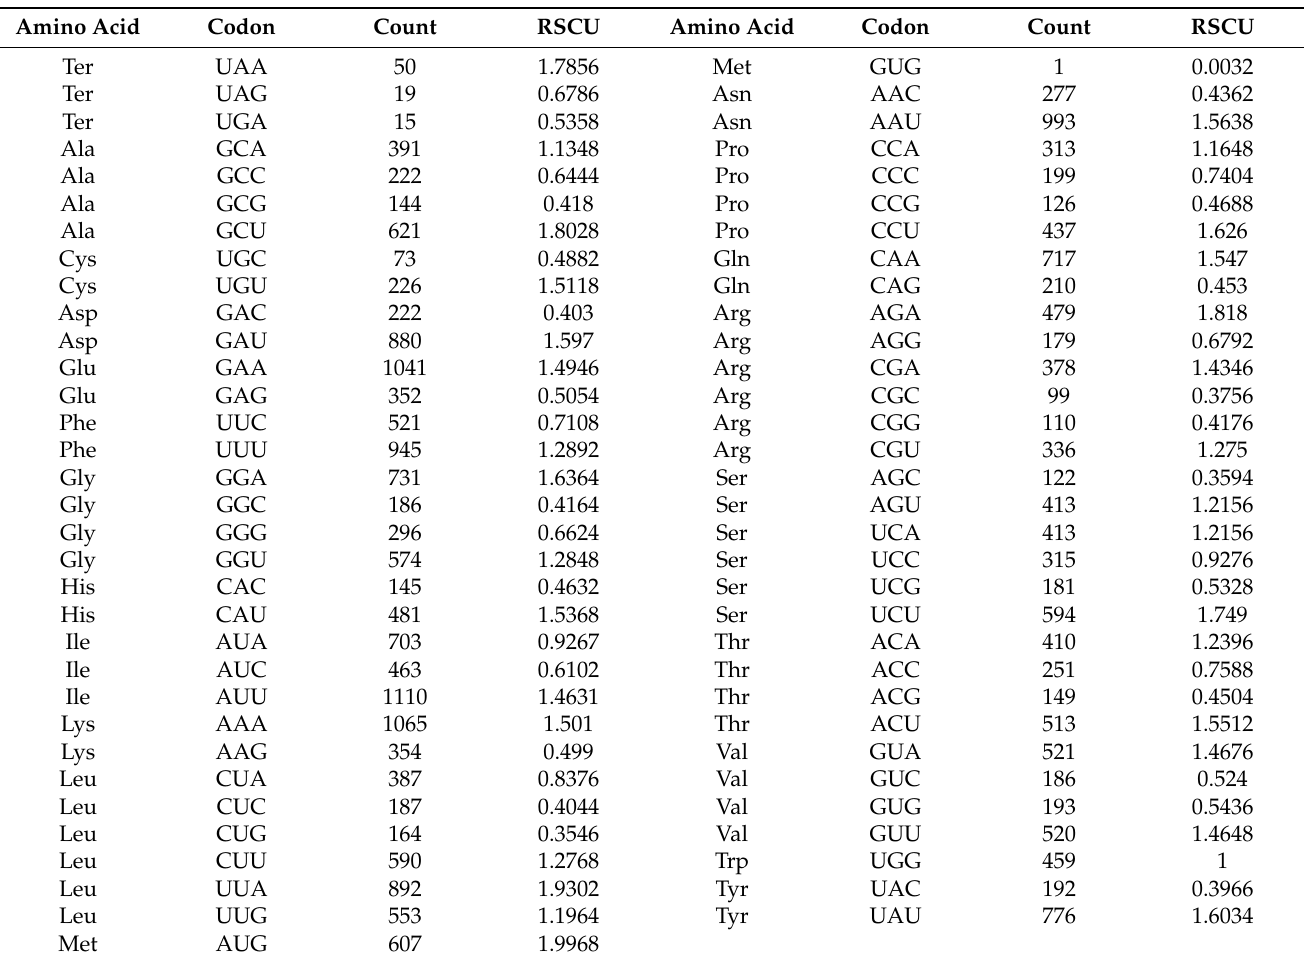
Table 4. Relative synonymous codon usage (RSCU) in the chloroplast genome of wild